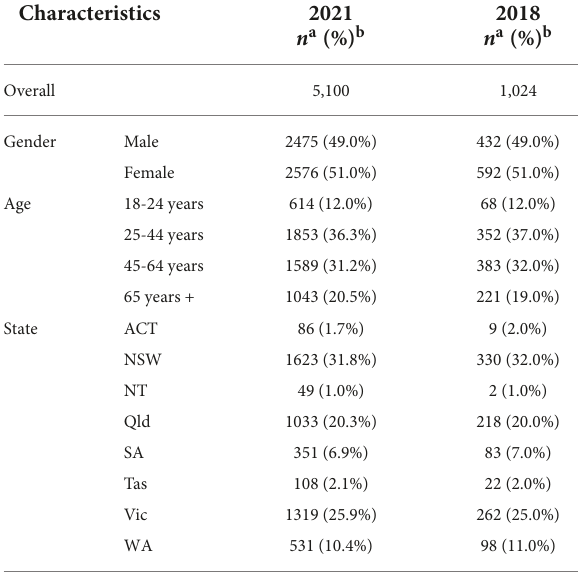
TABLE 1 Study participant characteristics across 2021 and 2018